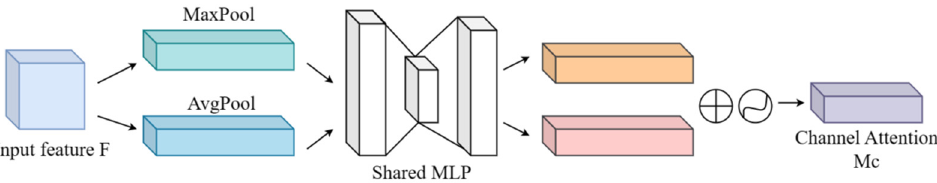
Figure 5. Channel a tt ention module. Figure 5. Channel attention module.